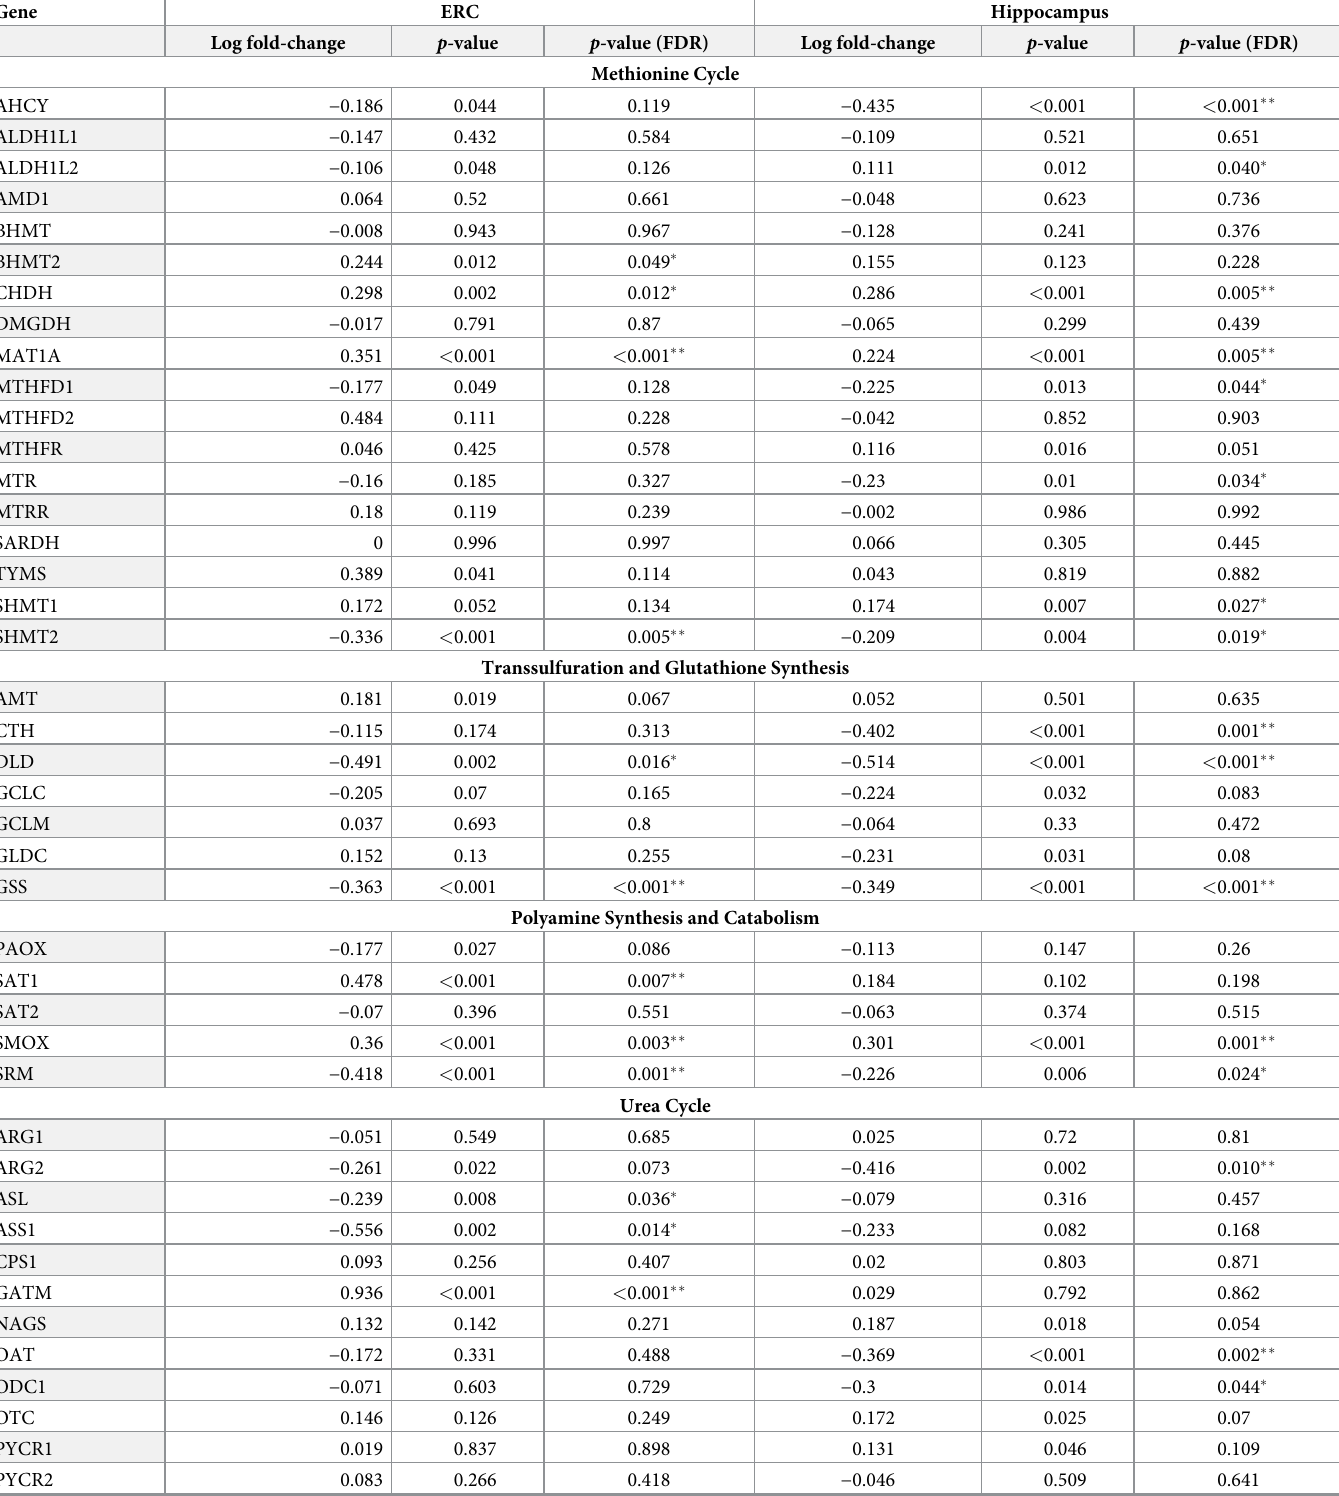
Table 3. Differences in gene expression between AD and CN participants across category-specific